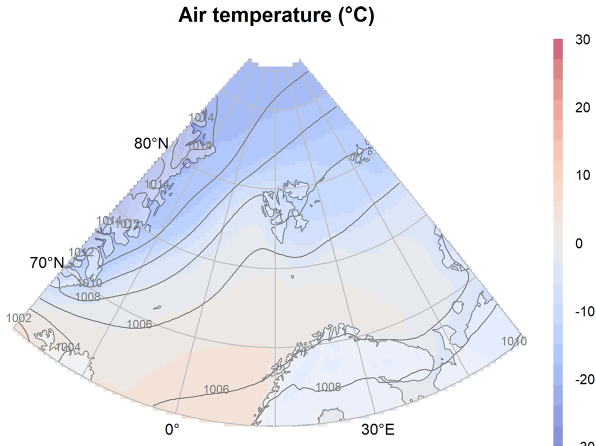
Figure B1. Mean daily air temperature composite field for all winter days ( n = 729) included in these analyses. This represents the mean daily air temperature conditions from which anomalies are calcu- lated. Composite MSLP isobars for all winter days are included for reference.